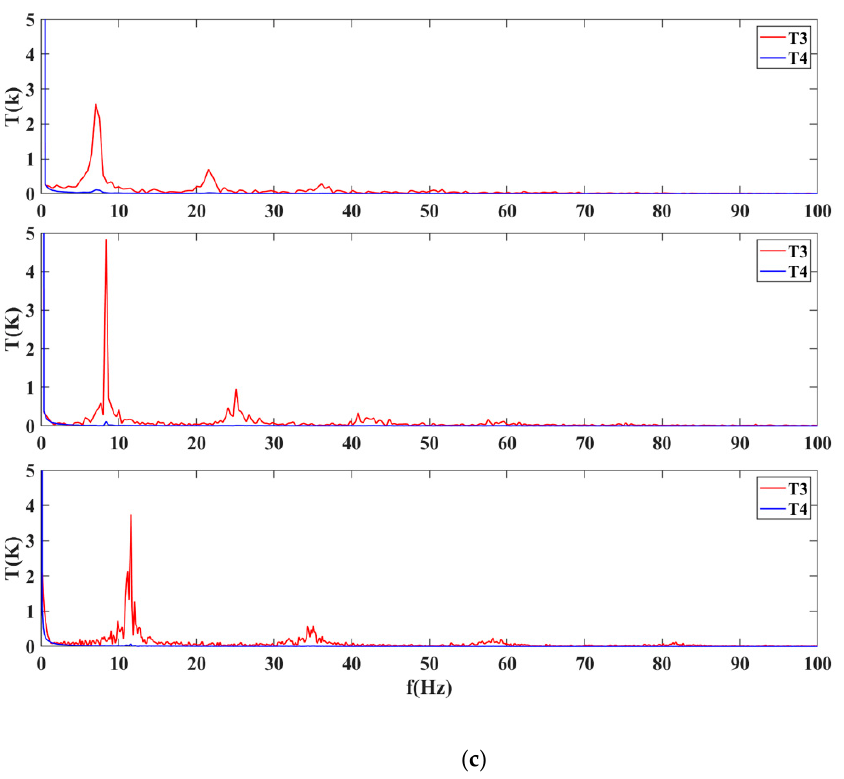
Figure 17. Simulation parameters of the different surges in the frequency domain. ( a ) Mass flow, ( b ) pressure, ( c ) temperature.